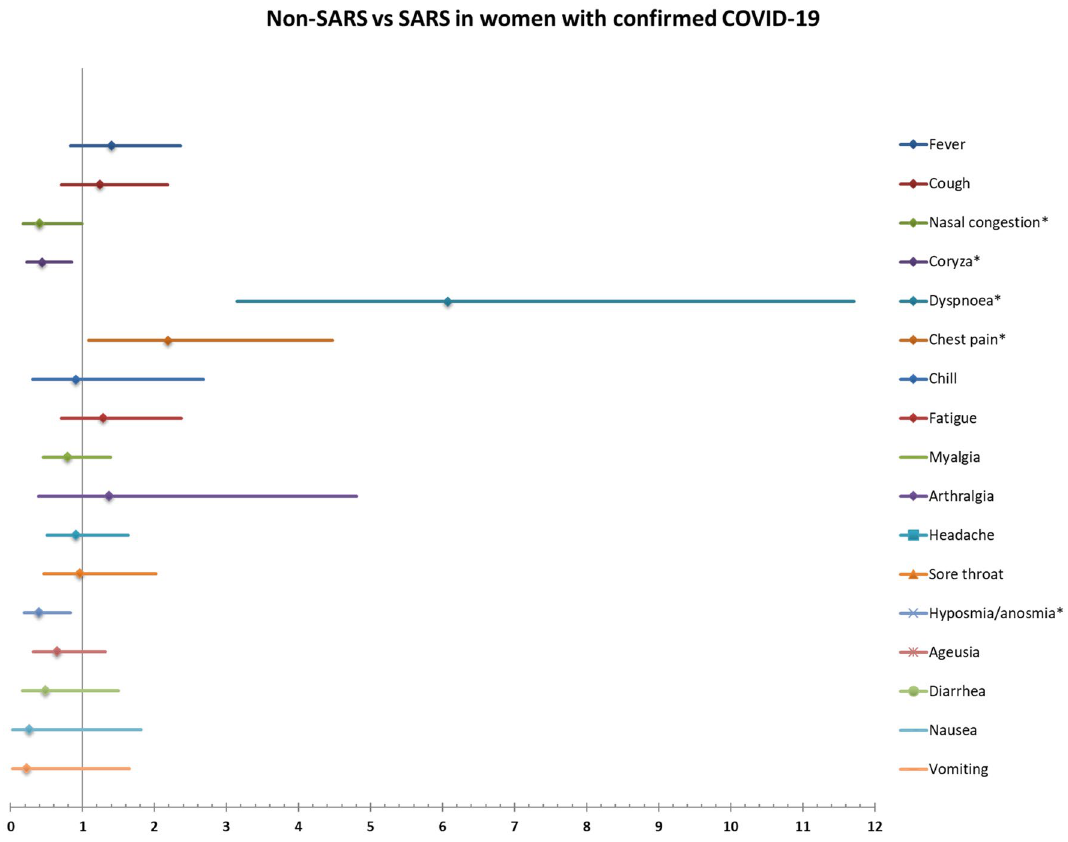
Figure 5. Risk ratios for SARS in women with confirmed COVID-19 according to symptoms at